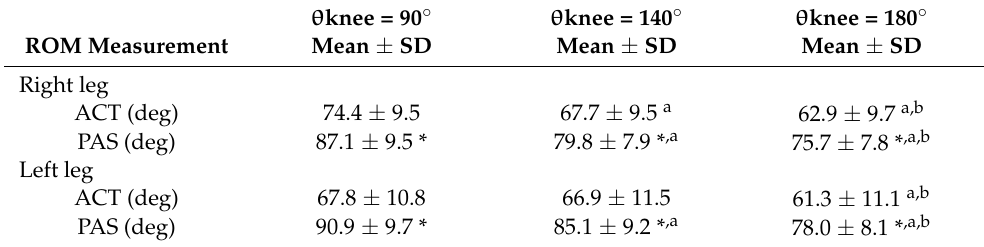
Table 1. Results for the ankle joint range of motion (ROM) measurements ( n = 35). θ knee = 90 ◦ θ knee = 140 ◦ θ knee = 180 ◦ ROM